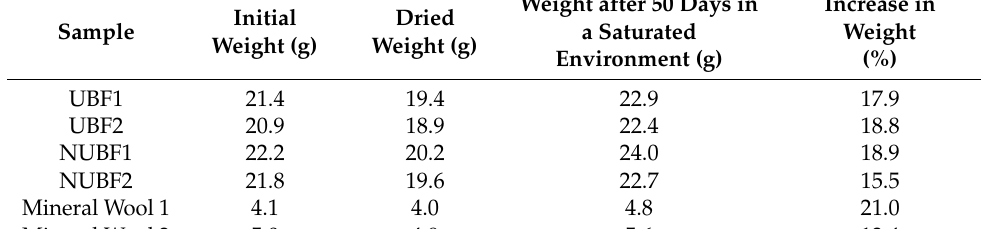
Table 1. Variation in weight of samples after initial drying and after remaining in a saturated envi- ronment for 50 days.